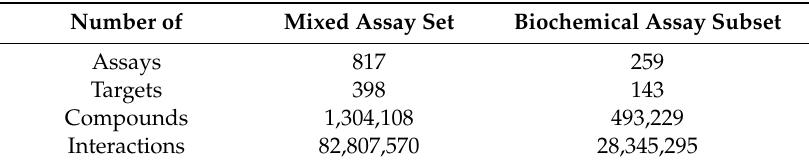
Table 2. Statistics for mixed and biochemical assay